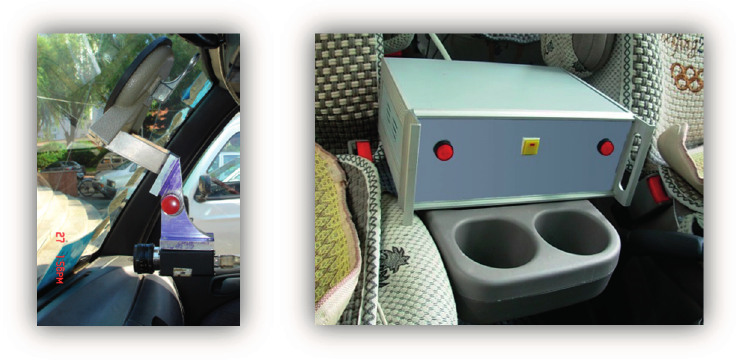
Figure 1. Hardware configuration for the proposed